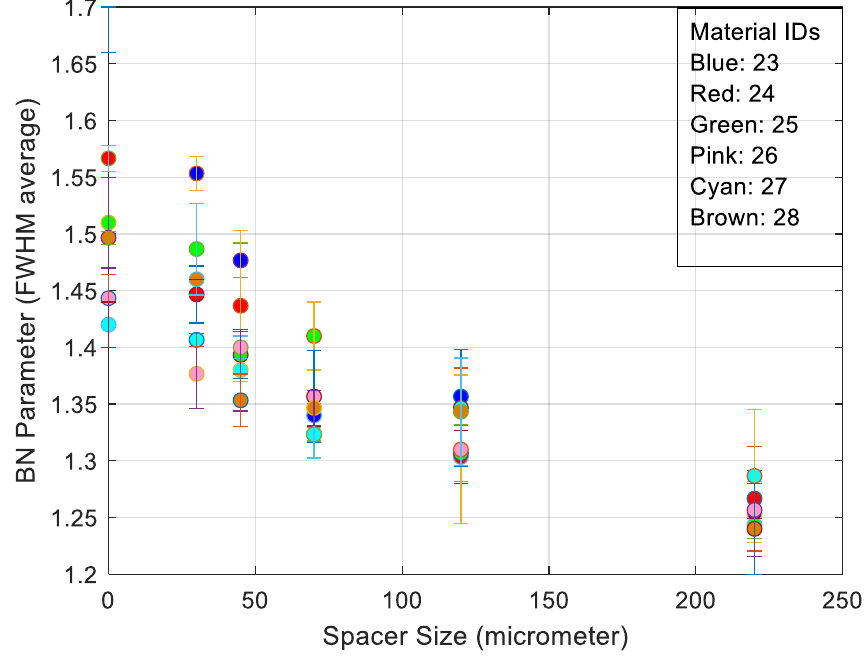
Figure 6. BN signal response, FWHM parameter for bottom surface in Transversal orientation.